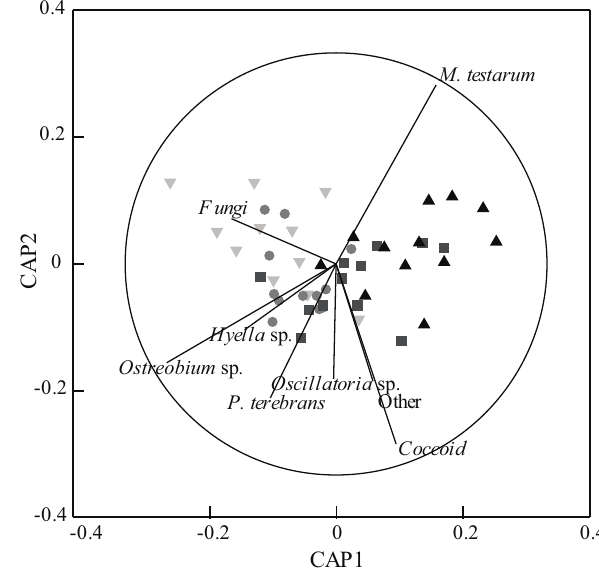
Figure 5. Canonical analysis of principal coordinates (CAP) of Fig 5. Canonical analysis of principal coordinates (CAP) of the endolithic community *)"! the endolithic community response to four p CO 2 -T scenarios over 8 weeks (pre-industrial: light-grey triangles; present day: circles; B1: squares; A1F1: black triangles). p CO 2 -T levels correspond to response to four p CO -T scenarios over 8 weeks (preindustrial = white triangles, present-day *)(! 2 -T treatment). pre-industrial (320µatm, 23 ◦ C), present-day (410µatm, 24 ◦ C), re- 2 duced (600µatm, 26 ◦ C), and business-as-usual (1000µatm, 28 ◦ C) = circles, B1 = squares, A1F1 = black triangles). p CO -T levels correspond to preindustrial *))! CO 2 emission 2 (320 µatm, 23°C), present-day (410 µatm, 24°C), reduced (600 µatm, 26°C), and business-as- *)#! usual (1000 µatm, 28°C) CO emission scenarios. 2